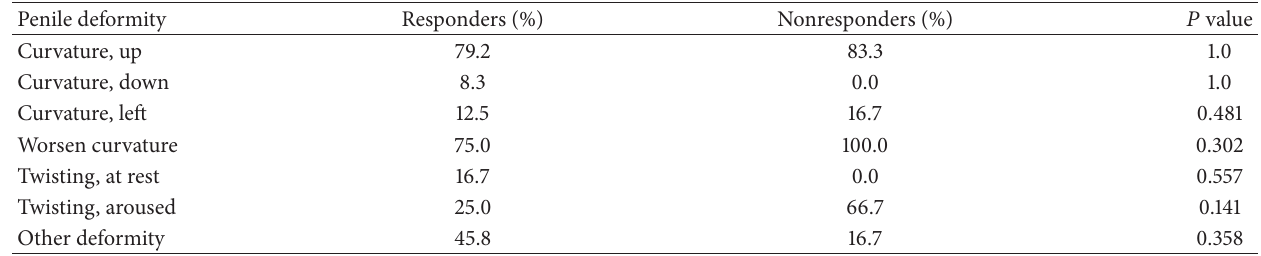
Table 3: Penile deformities including curvature, twisting, and other deformities among responder and nonresponder men, expressed as percentage.